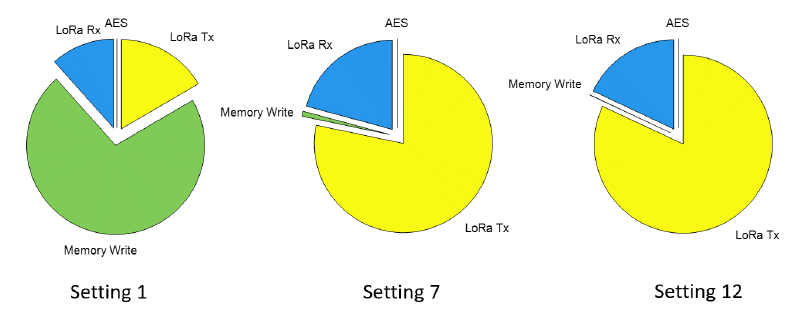
Figure 9. The energy consumption breakdown for the secure